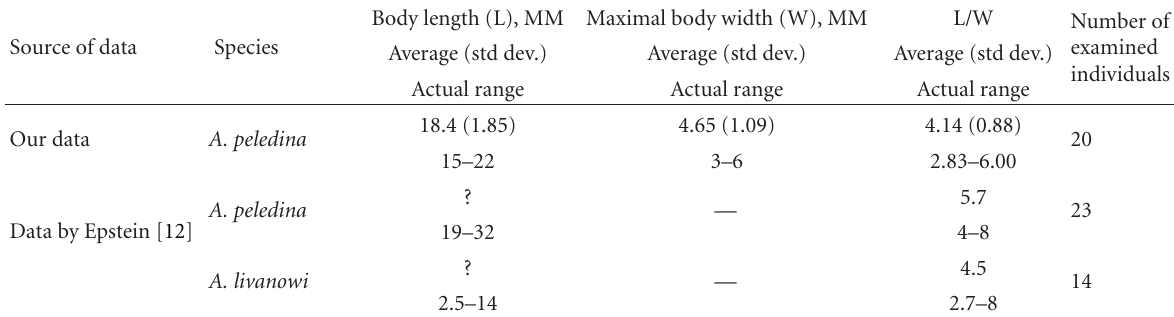
Table 3: The body ratios of specimens from the Chechuj River and similar data by Epstein.